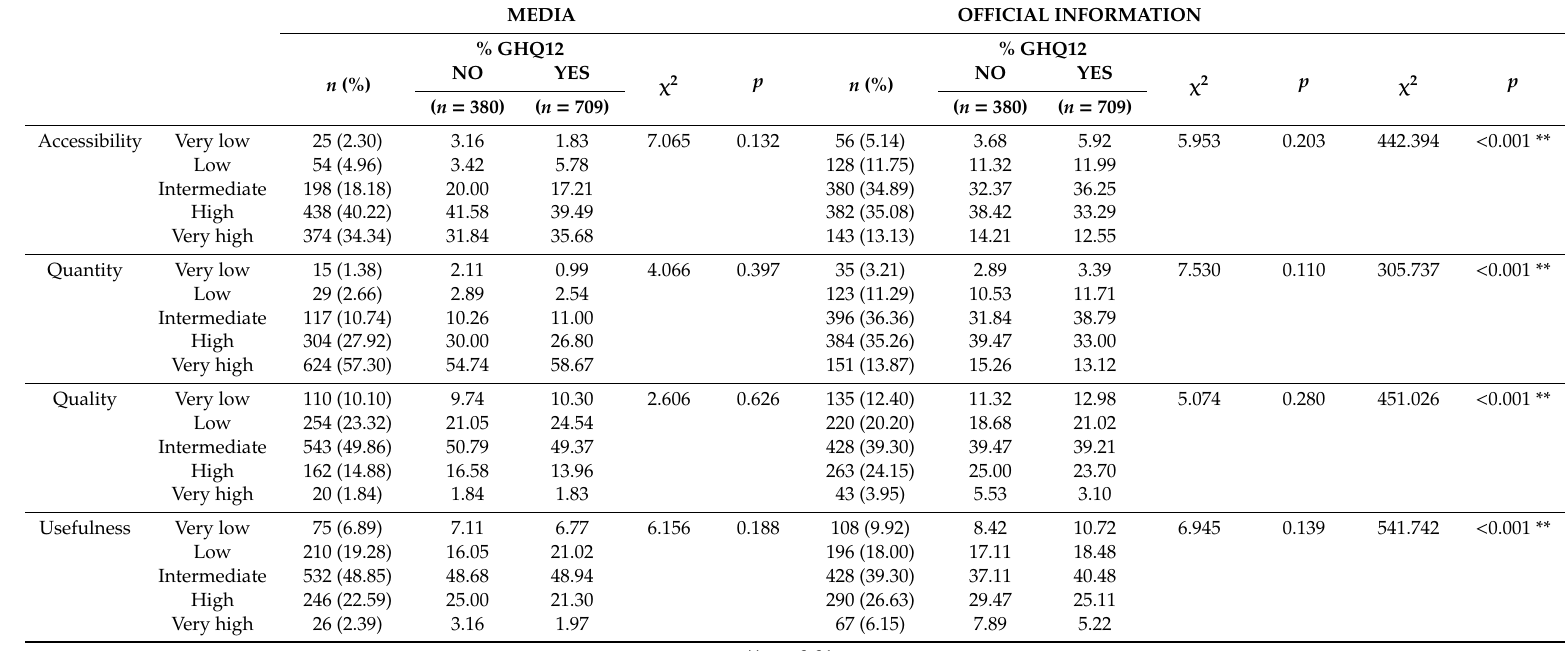
Table 2. Association between information o ff ered about the pandemic and psychological distress among non-health workers working during the pandemic. MEDIA